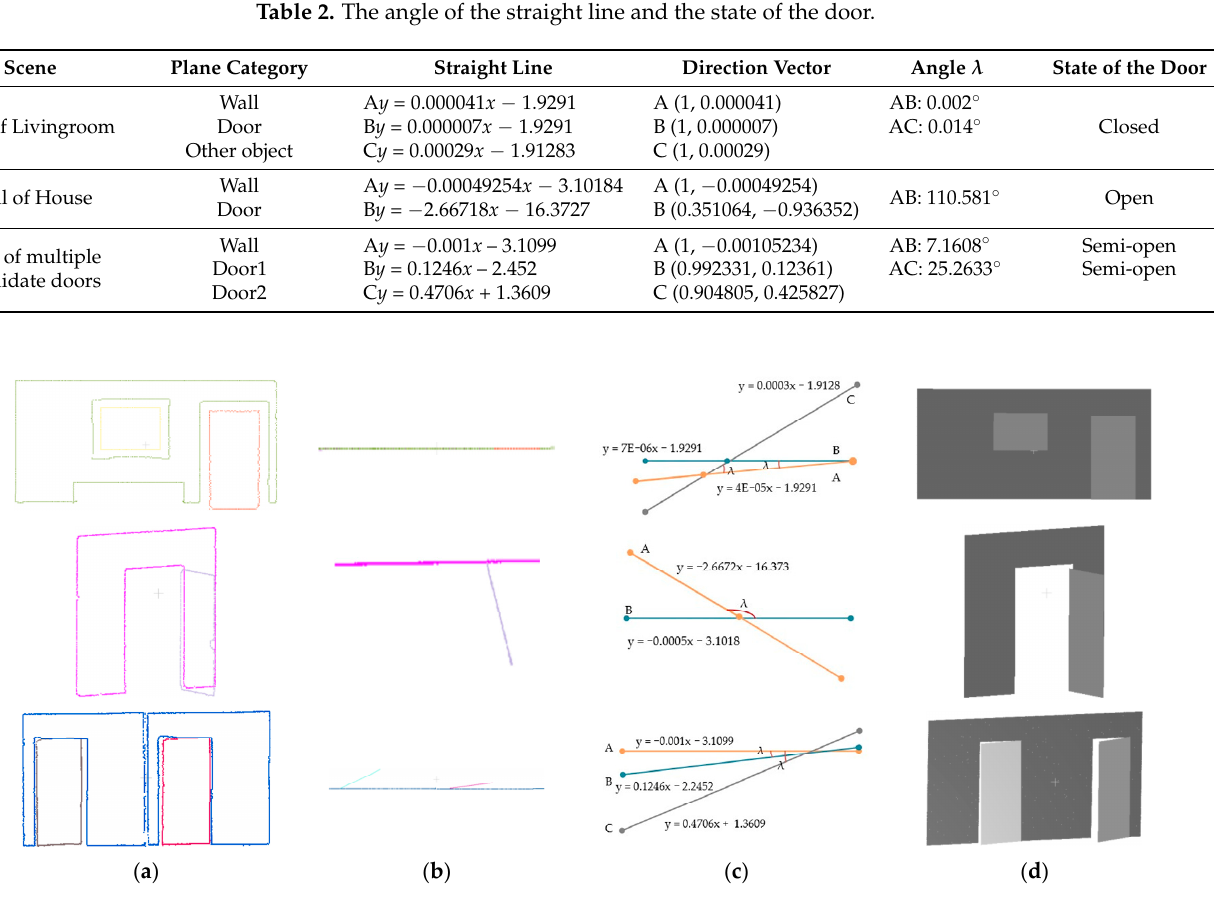
Figure 11. Reconstruction results. ( a ) Boundary point; ( b ) projection point; ( c ) straight-line fitting; ( d ) wall model.